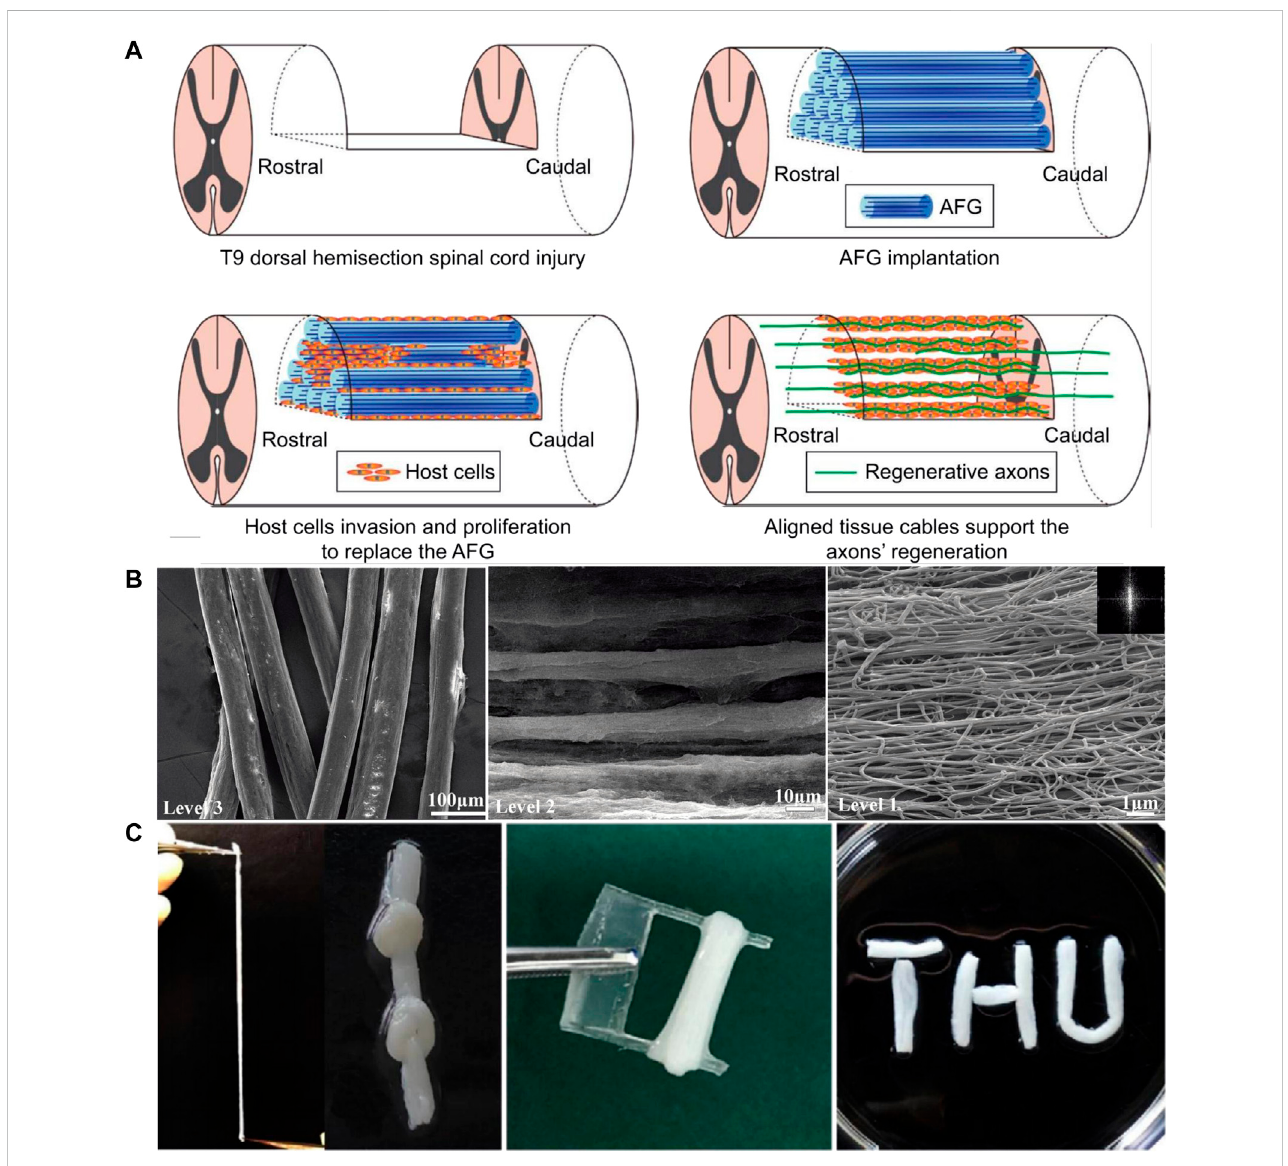
FIGURE 5 Characteristicsofaligned fi brinhydrogel. (A) Schematicillustrationofthemechanismfortheaxonalregrowthprocesswiththeinvolvementofanaligned scaffold. Taken from (Yao et al., 2018). (B) SEM images of AFG at different magni fi cations showing hierarchically aligned organizations. [Reprinted with permission from Ref.(Yaoetal., 2016).Copyright2016 Royal Societyof Chemistry]. (C) MechanicalcharactersoftheAFG. The AFG can bestretched, knotted, twined, and clipped. [Reprinted with permission from Ref. (Cao et al., 2020). Copyright 2020 Springer